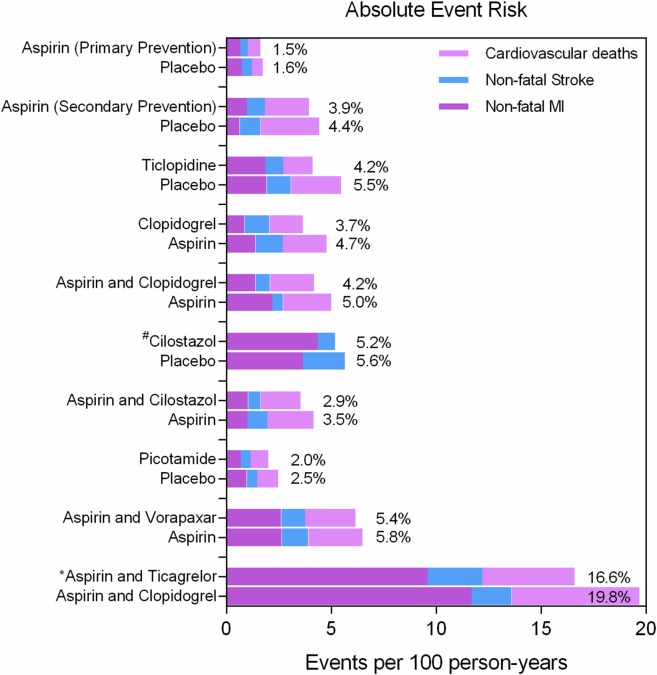
Observed risk of events in control and active arms of included RCTs.Aggregate risks of events are reported for each node and expressed as percent person-years. # In case of the Cilostazol versus placebo trials the numbers of cardiovascular deaths were not available separately, but fatal and no-fatal MIs and strokes were reported. * The PLATO trial included patients with acute coronary syndrome (ACS) at baseline.